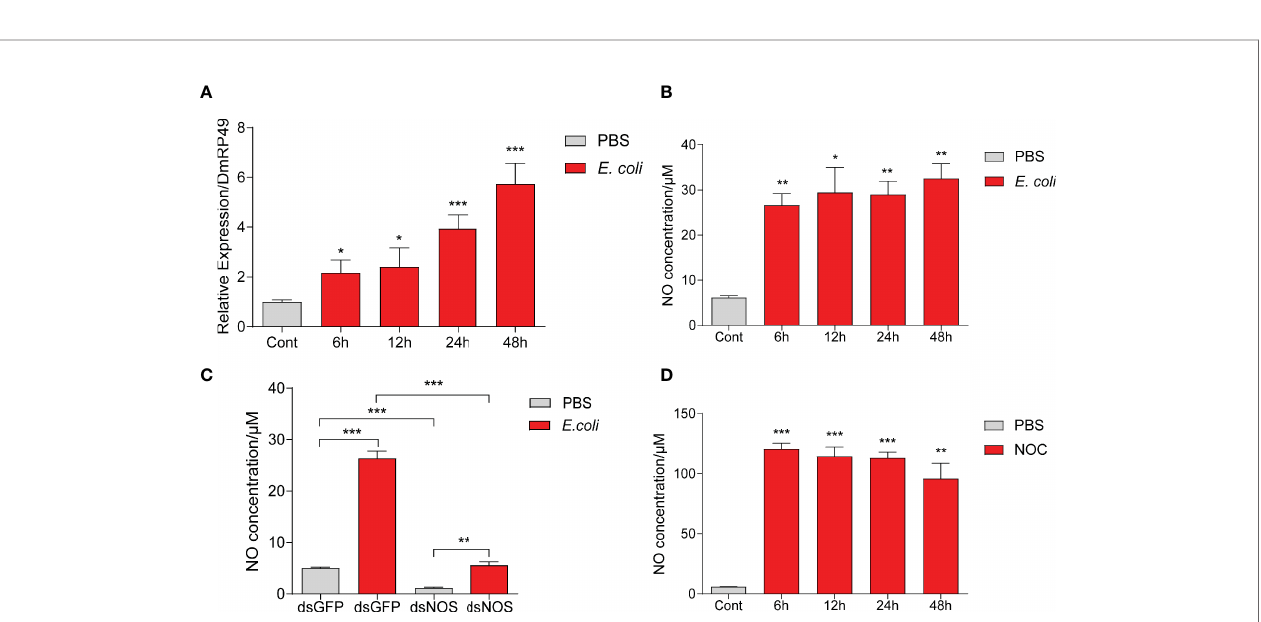
FIGURE 4 | E coli and NOC treatments stimulated NO production in Drosophila S2 cells. NOS mRNA levels (A) and NO concentrations (B) after E coli infection. NO levels in the medium samples after NOS RNAi and treatment with killed E coli (C) or the NOC (D) . Cont, PBS treatment at 0 h One-way ANOVA followed by Tukey ’ s test was used to compare control and treatment groups (A, B, D) . Student ’ s t-test was used to analyze signi fi cance in (C) . * p < 0.05; ** p < 0.01; *** p <